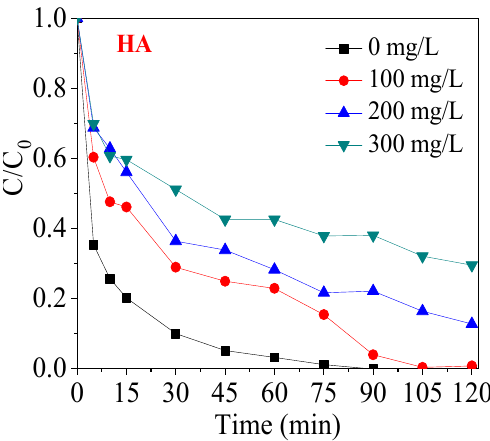
Figure 7. Effect of HA on removal of Cr(VI) by nZVI in solution. ([Cr(VI)] = 25 mg/L, [nZVI] = 0.5 g/L, pH = 3, T = 293 K, Time = 120 min).